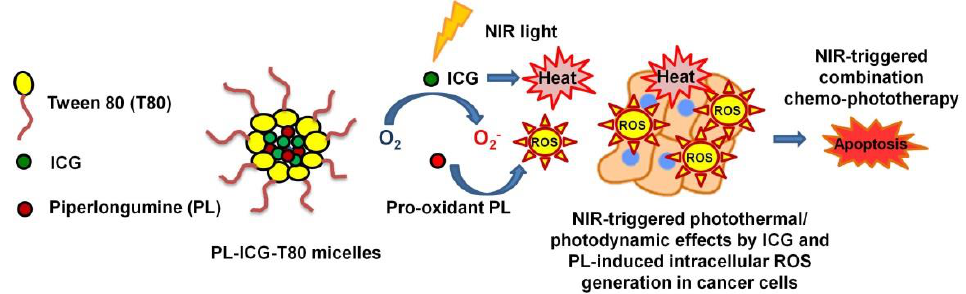
Figure 11. PL- and ICG-loaded PS 80-based NPs for combination chemo/photothermal/photodynamic therapy. Reproduced with permission from Reference [150]. Copyright 2020, Elsevier